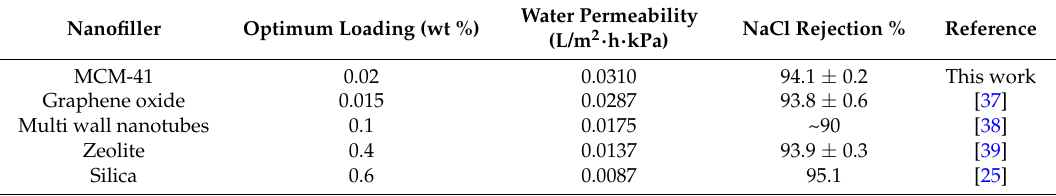
Table 2. A performance comparison of thin film nanocomposite (TFN)